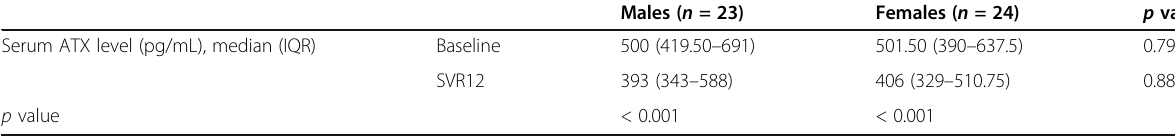
Males ( n = 23) Females ( n = 24) p value